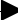
Fig. 2. a. Top: AE index for 27 August 1979. The time of Event 1 is marked by a black arrow . Bottom: Map in coordinates MLT- inv. lat. showing the single discrete arc ( dashed line ) observed in the field of view of the all-sky camera at Molodezhnaya during the NOAA-6 satellite pass for Event 1. Approximate field of view of the all-sky camera is shown by the solid-line oval . Trace of the satellite is shown by solid line . The electron and proton IBs are shown on the trace of the satellite by open circles and asterisks . b Likewise for Event 2. c Event 3. d Event 4. e Event 5. The IBs were obtained from the TIROS satellite measurements. f Event 6. The IBs were obtained from the TIROS satellite measurements. g Event 7. Both discrete and di(cid:128)use auroras were observed in this case. The di(cid:128)use aurora is shown by the hatched area . The IBs were obtained from the TIROS satellite measurements. h Event 8. The di(cid:128)use aurora observed from Novolazarevskaya is shown by the dotted area . Note that there was no discrete aurora in this case. The IBs were obtained from the TIROS satellite measurements. i Event 9. Both discrete and di(cid:128)use auroras were observed in this case from Novolazarevskaya. Note